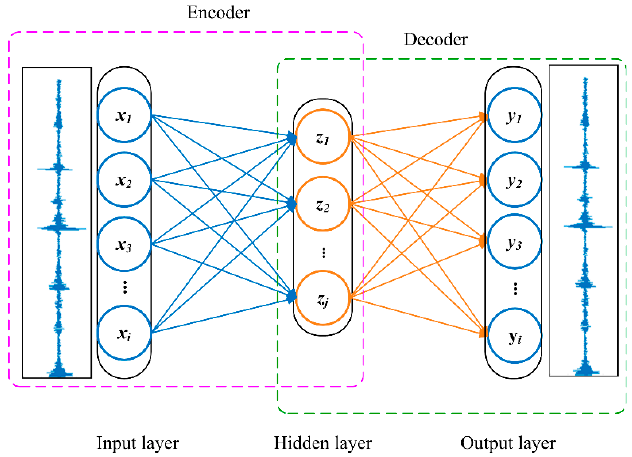
Figure 1. The basic architecture of an autoencoder (AE).